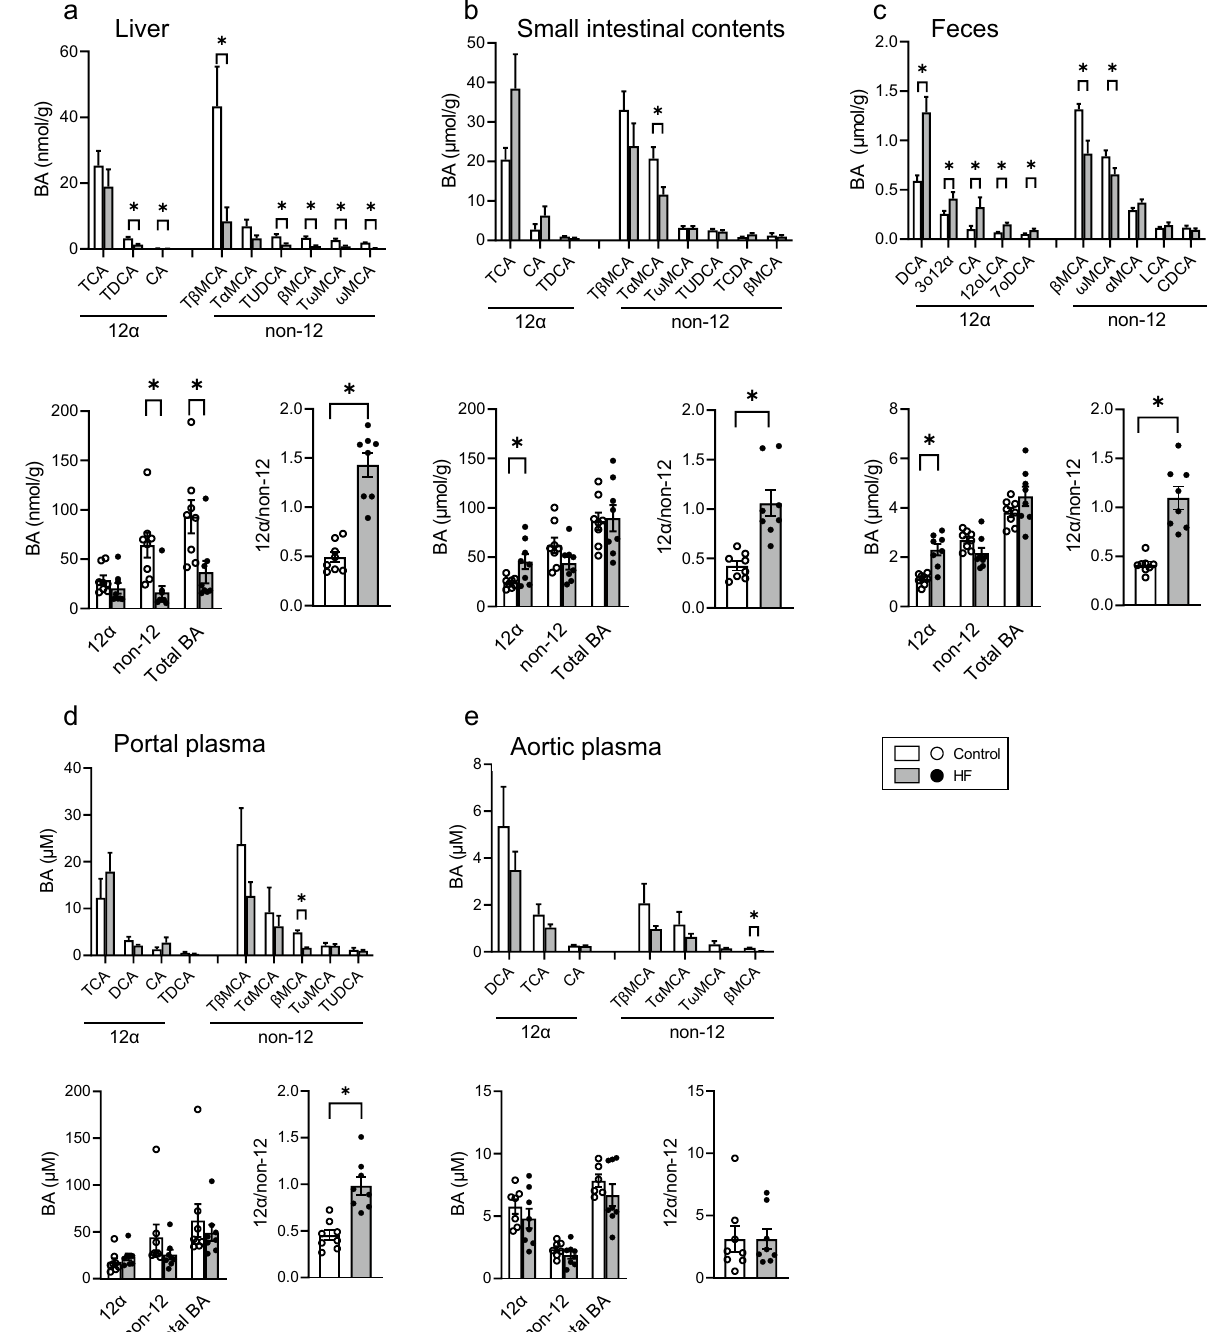
Figure 2. BA compositions in the liver, small intestine contents, and feces of mice fed control and HF diet. BA composition; 12α, non-12, and total BA concentrations; and the ratio of 12α BA/non-12 BA in the ( a ) liver, ( b ) small intestinal contents, ( c ) feces, ( d ) portal plasma, and ( e ) aortic plasma. Open bars represent control (n = 8) and filled bars represent HF (n = 8). Values are shown as mean ± SEM (n = 8). Asterisks indicate a significant difference compared with the control ( P <